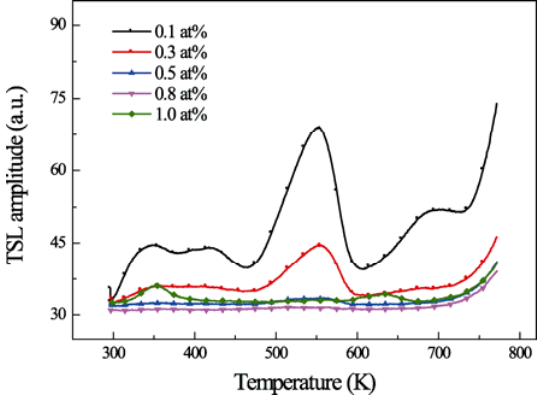
Fig. 7 TSL glow curves of LuAG–Al 2 O 3 nanoceramics (72 mol% Al 2 O 3 ) with different Ce concentrations (1100 ℃ , 2 h) measured within the temperature range of 300–780